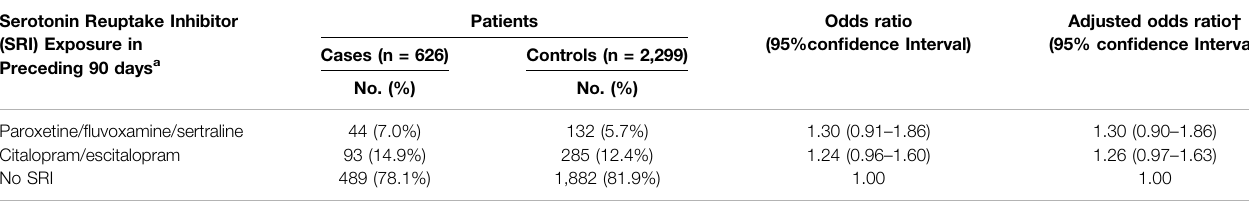
Frontiers in Pharmacology |